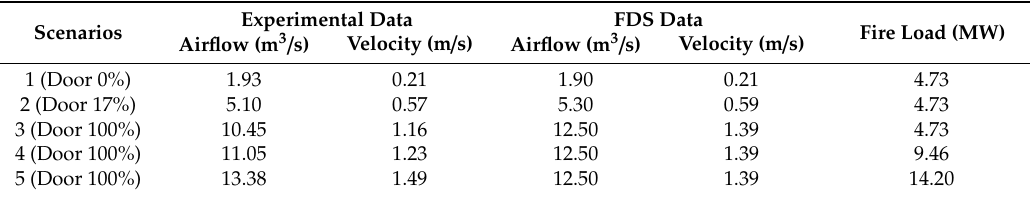
Table 2. Values used in the di ff erent scenarios. FDS—fire dynamics